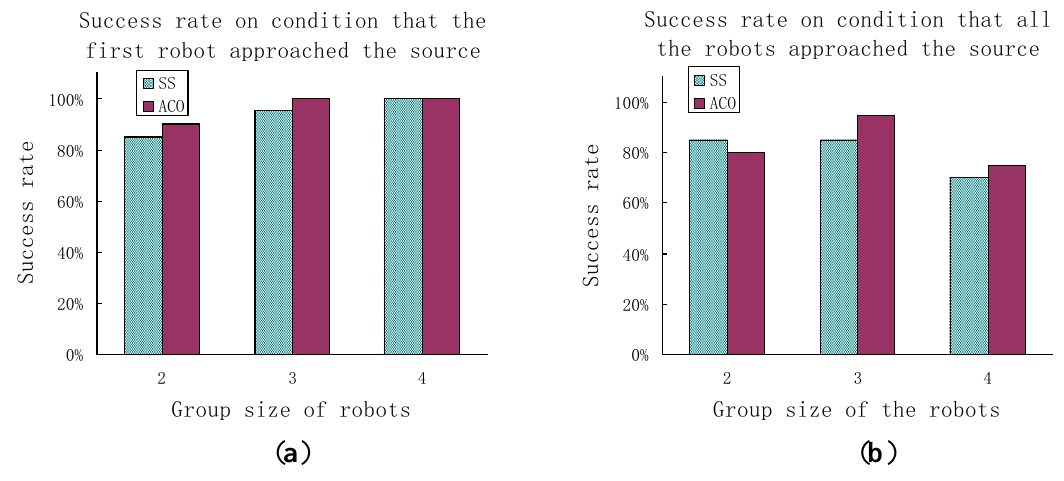
Figure 17. The success rate for the CPT task in Arena I: ( a ) Success rate on condition that the first robot approached the source; ( b ) Success rate on condition that all the robots approached the odor